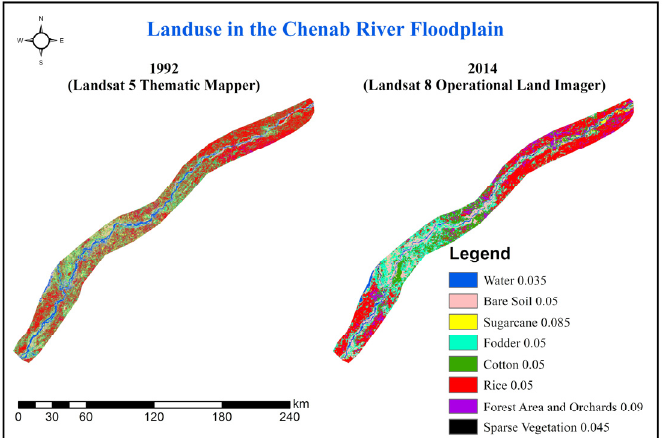
Figure 5. Floodplain landuse of the Chenab River for 1992 and 2014, developed using the Landsat 5 Thematic Mapper and the Landsat 8 Operational Land Imager, respectively.